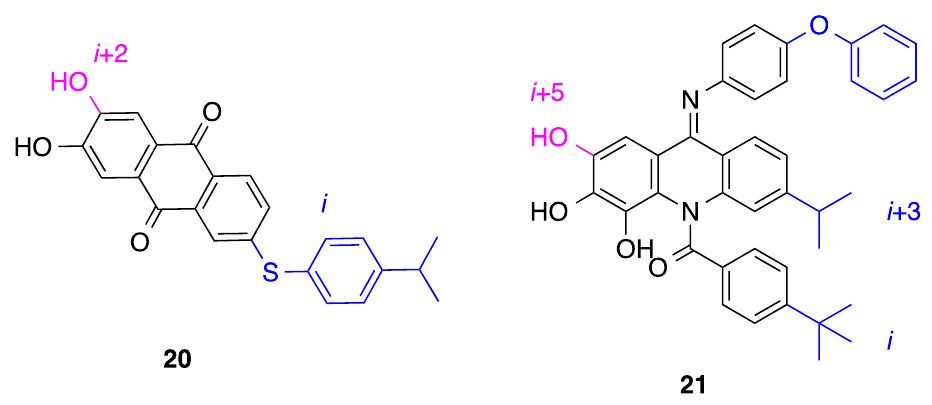
Figure 8. Appropriately functionalized anthraquinones ( left ) and acridines ( right ) have disrupted the Bim–Mcl-1 PPI through two-faced mimicry of the Bim-BH3